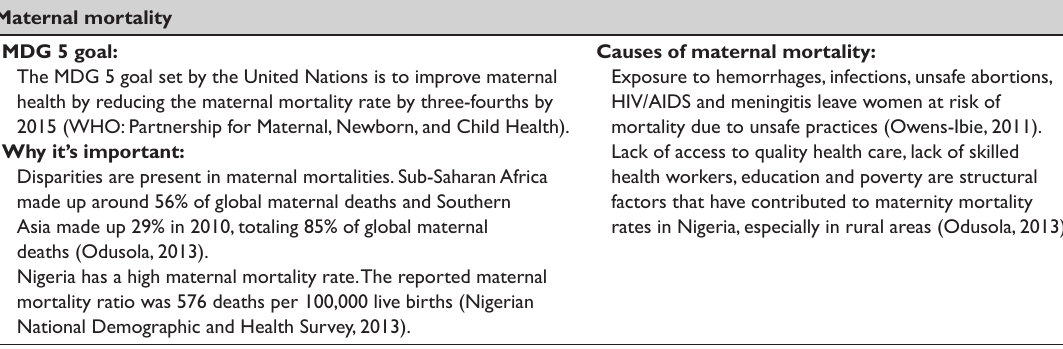
Table 1: Millennium development goals and maternal mortality Maternal